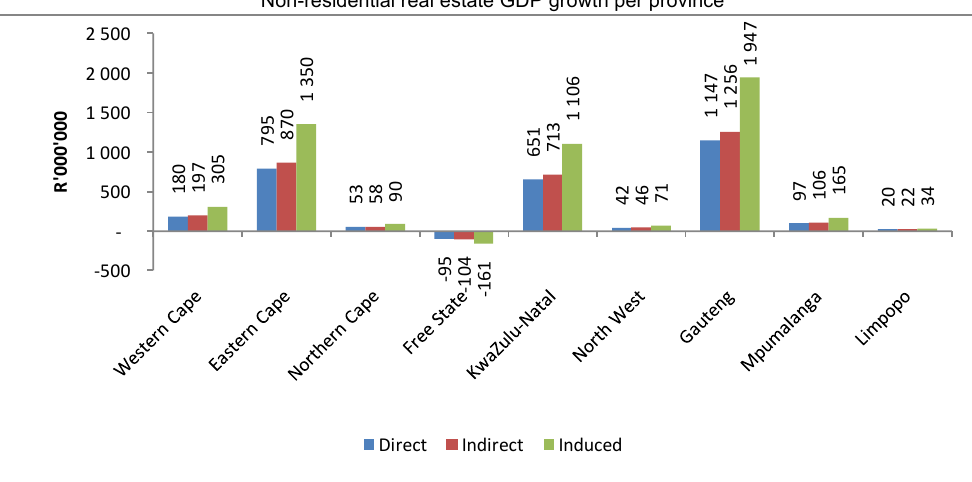
Figure 34 Non-residential real estate GDP growth per